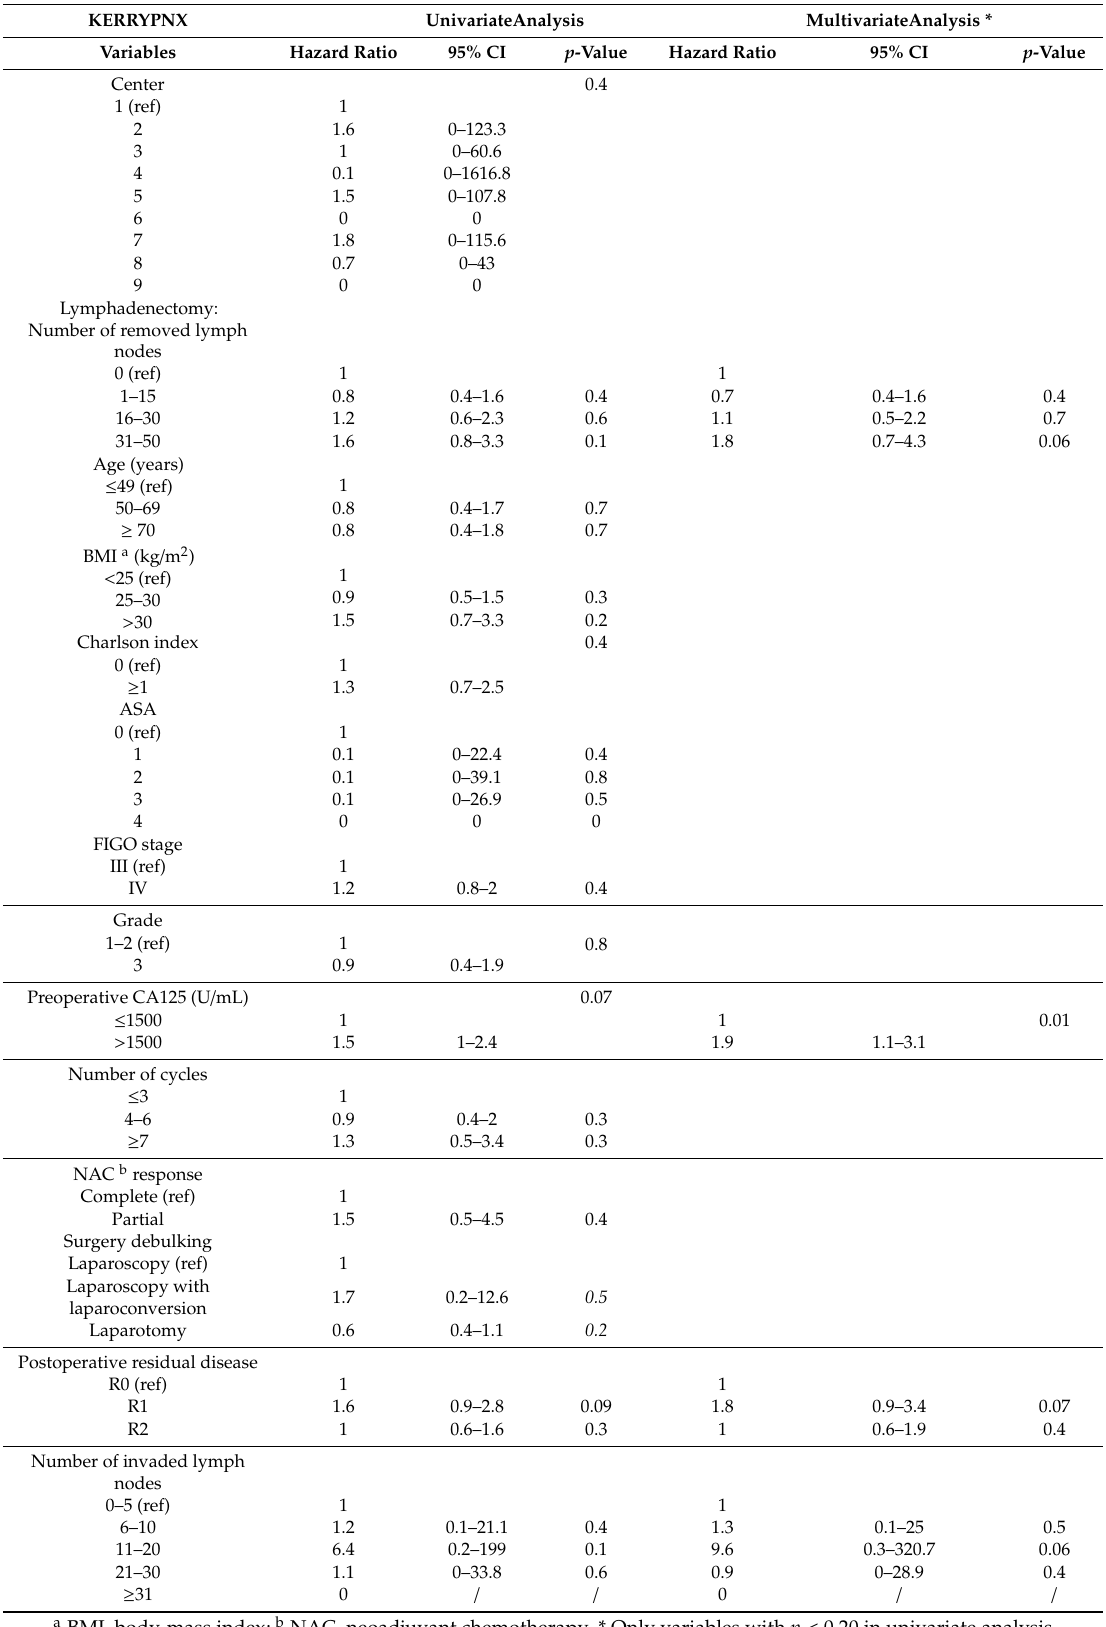
Table 4. Cox regression analysis for overall survival